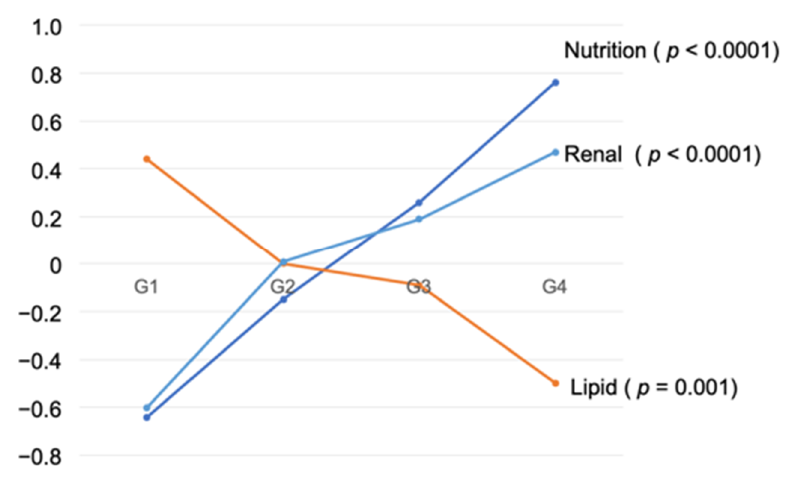
Figure 4. Mean of synthetic variable by Four Groups. The odds of a subject being classified into higher risk group (i.e., group membership j (=1,2,3,4) increase) were 1.26 times when value of the synthetic variable “Nutrition” increased 1 point (Table